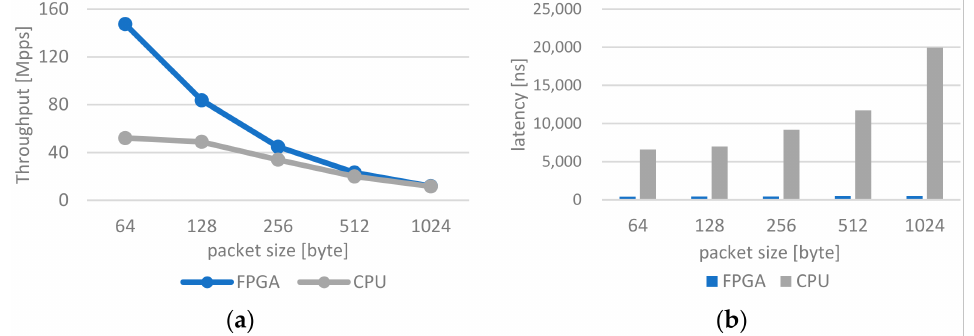
Figure 22. Packet forwarding performance comparison between FPGA and CPU. ( a ) The respectively achieved highest throughputs; ( b ) the generated latency of packet forwarding performed by FPGA and